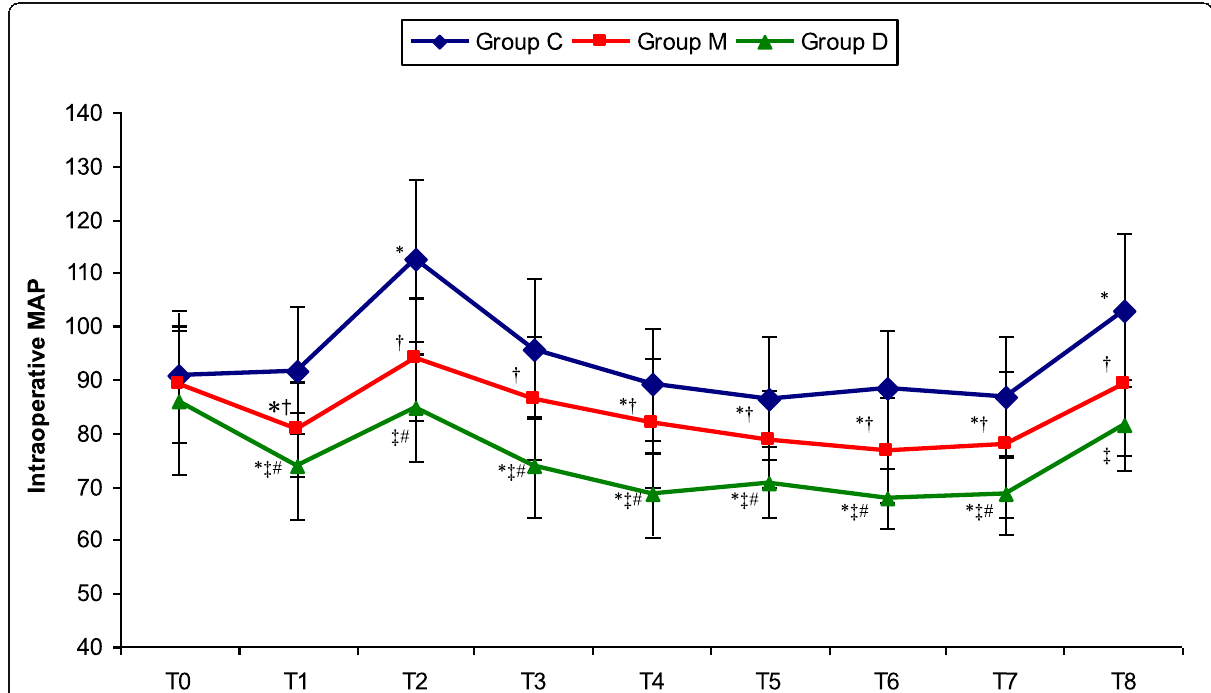
Fig. 2 Intraoperative MAP recordings expressed as mean ± SD. * P < 0.05 (compared with baseline value), † P value < 0.05 (group M compared with group C), ‡ P < 0.05 (group D compared with group C), # P < 0.05 (group D compared with group